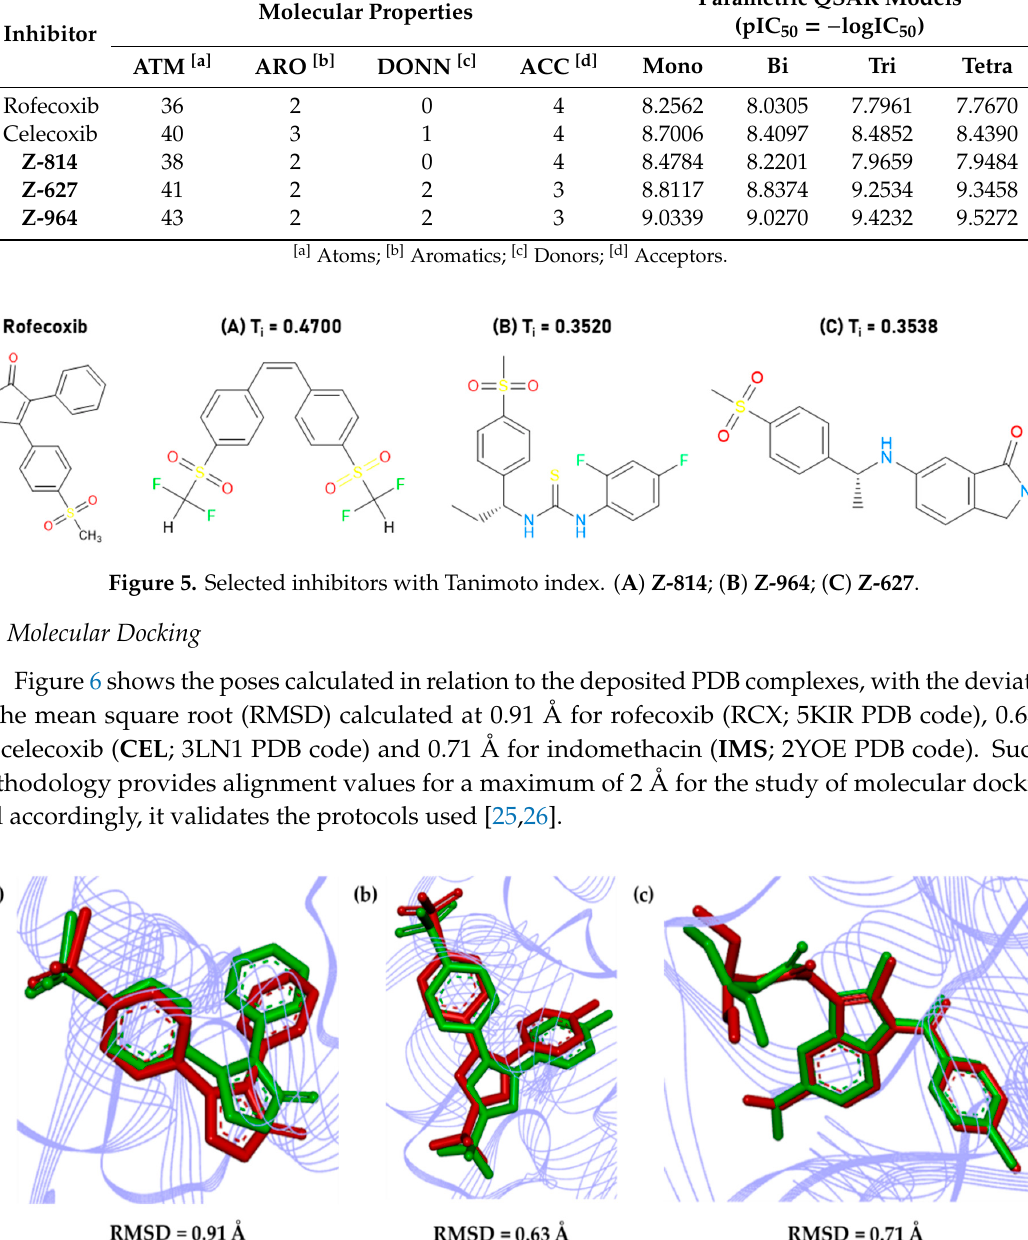
Table 13. Predicted pIC 50 values of the selected inhibitors and controls.